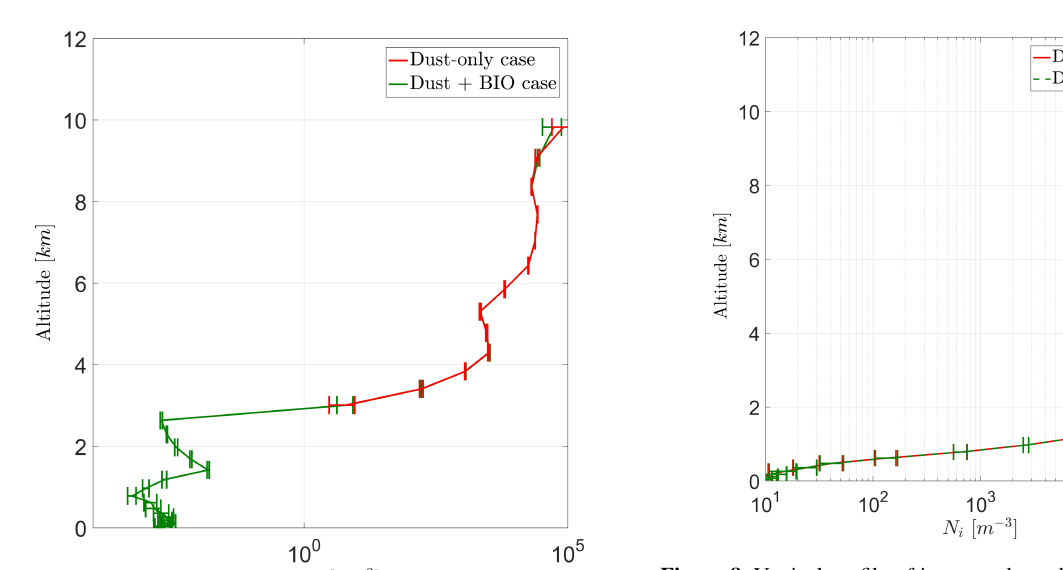
Figure 8. Vertical profile of ice crystal number concentration ( N i ) averaged over the entire domain for both cases (DST and BIO).